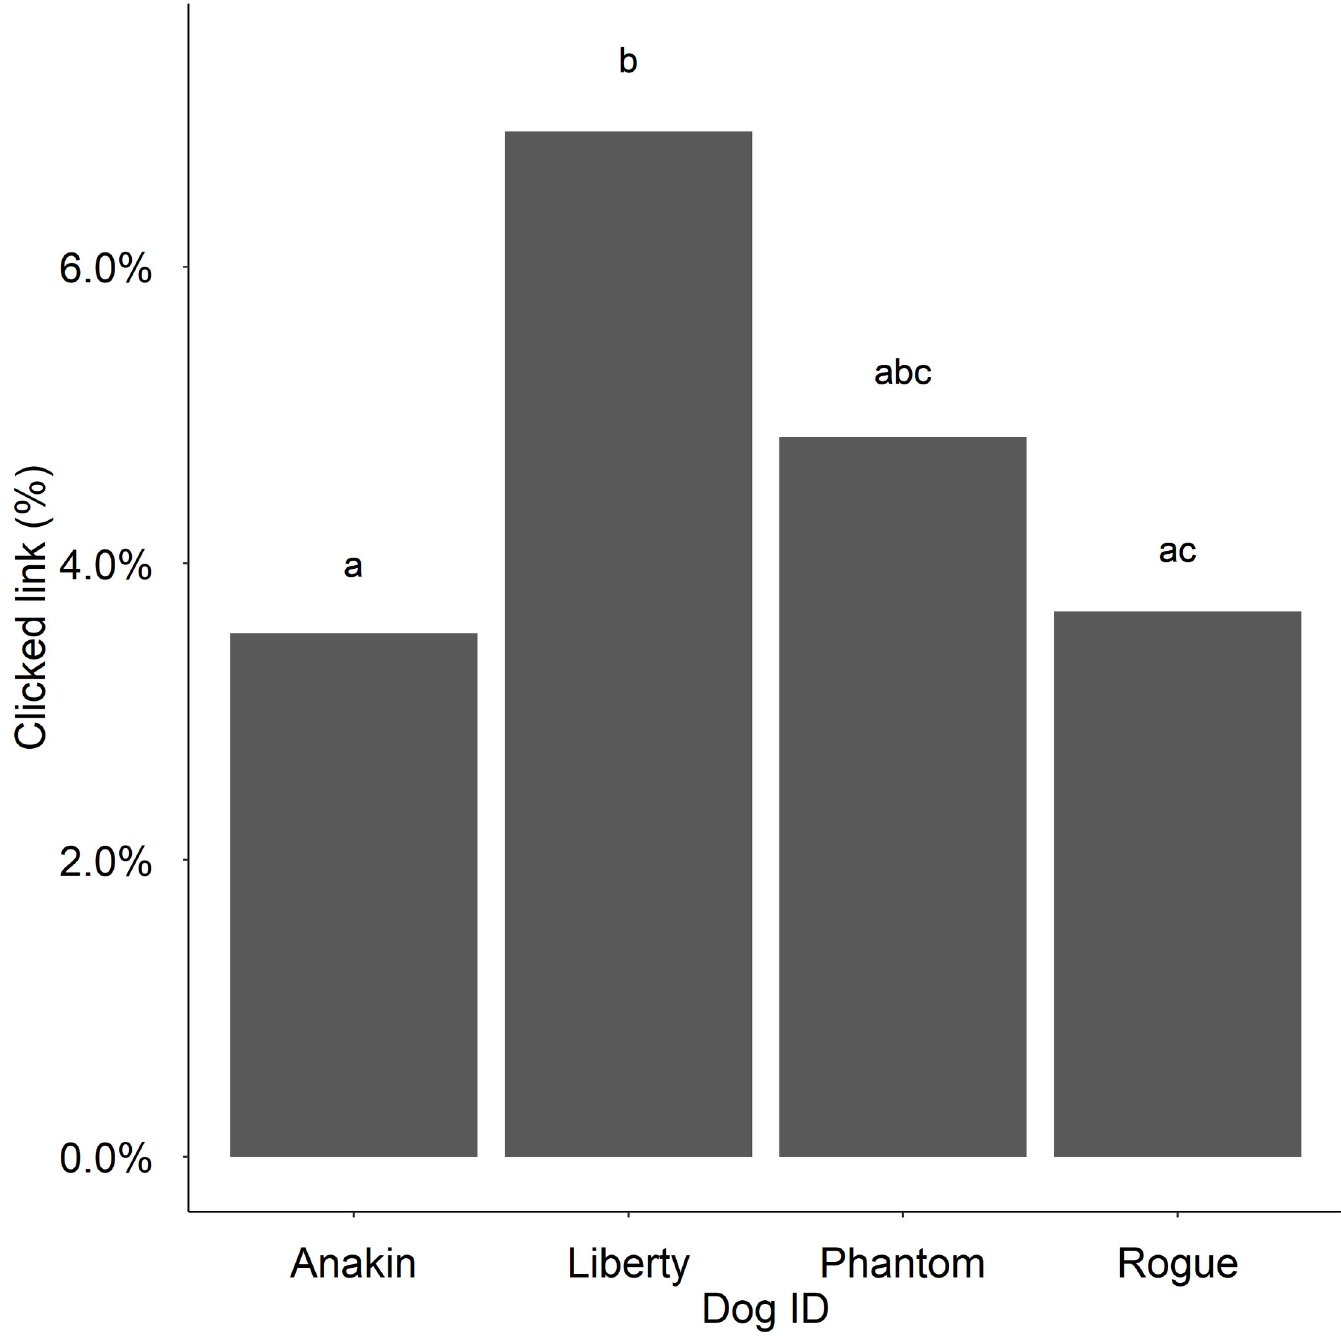
Fig 3. Link clicking by dog type. The percentage of link clicking responses on each dog photo.